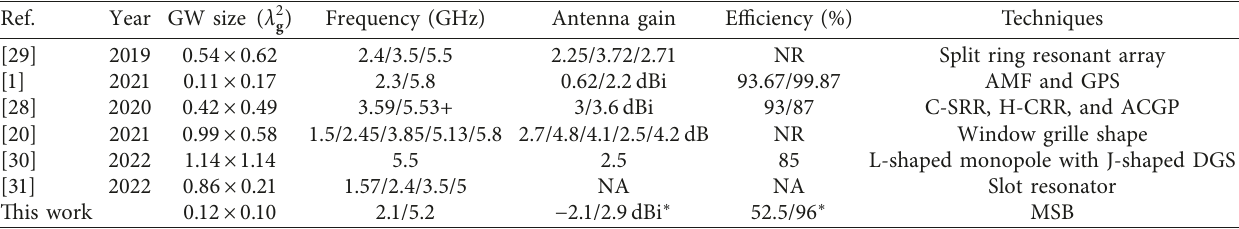
Table 2: MSB antenna’s comparative analysis with the existing works in the literature.